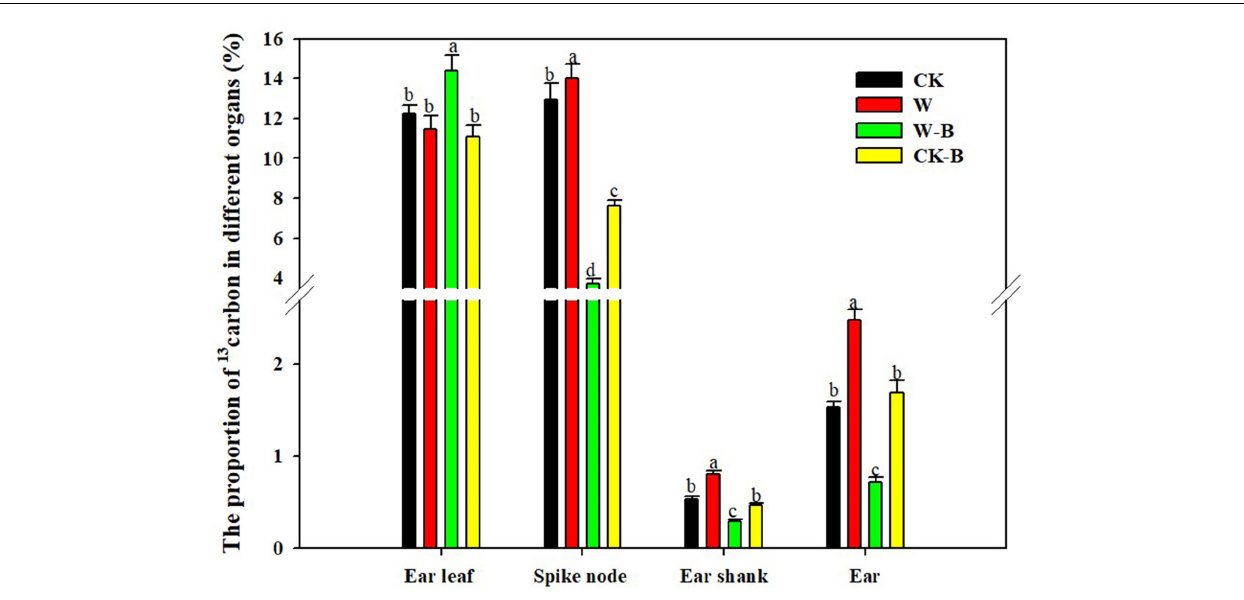
FIGURE 2 | The effects of 6-BA on the 13 C distribution in summer maize. CK, control, no waterlogging stress; CK-B, spraying 6-BA on non-waterlogged plants; W, waterlogging; W-B, spraying 6-BA after waterlogging. Different letters on bars indicate the significant differences among treatments at P < 0.05 using the LSD test.